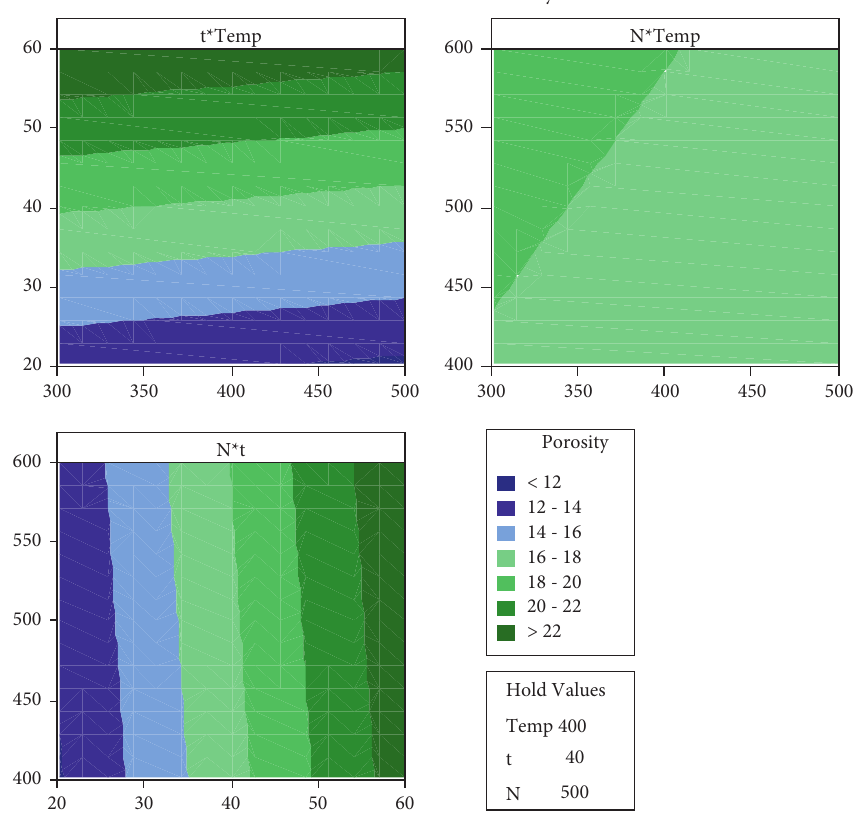
Figure 4: Contour plots comparison for porosity (temp: temperature in ° C; t : time in sec; N : stir speed in rpm).